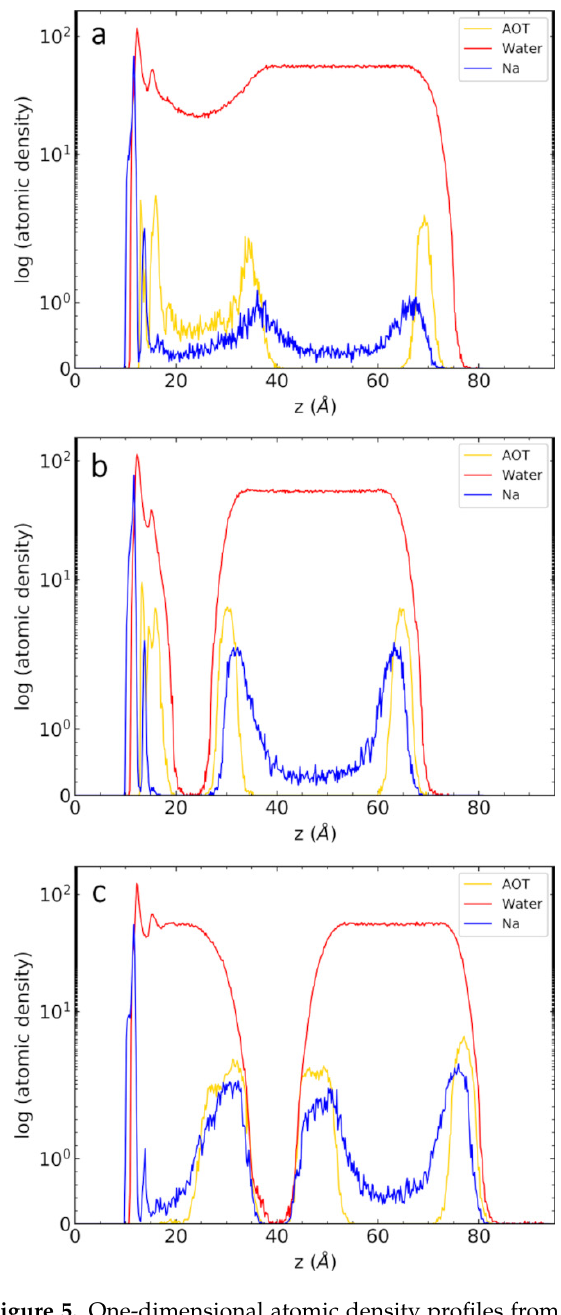
Figure 5. One-dimensional atomic density profiles from MD simulations with ( a ) 32, ( b ) 48, and ( c ) 64 AOT with Na + at 300 K. Profiles are shown for water oxygen atoms (red), AOT (sulfur atoms, yellow), and Na + (blue).